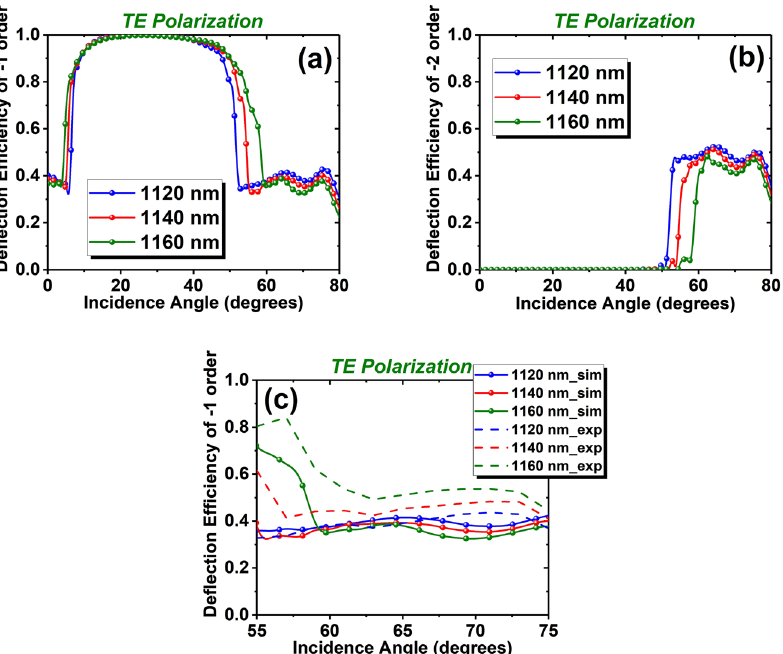
Figure 6: Beam splitter functionality of the designed